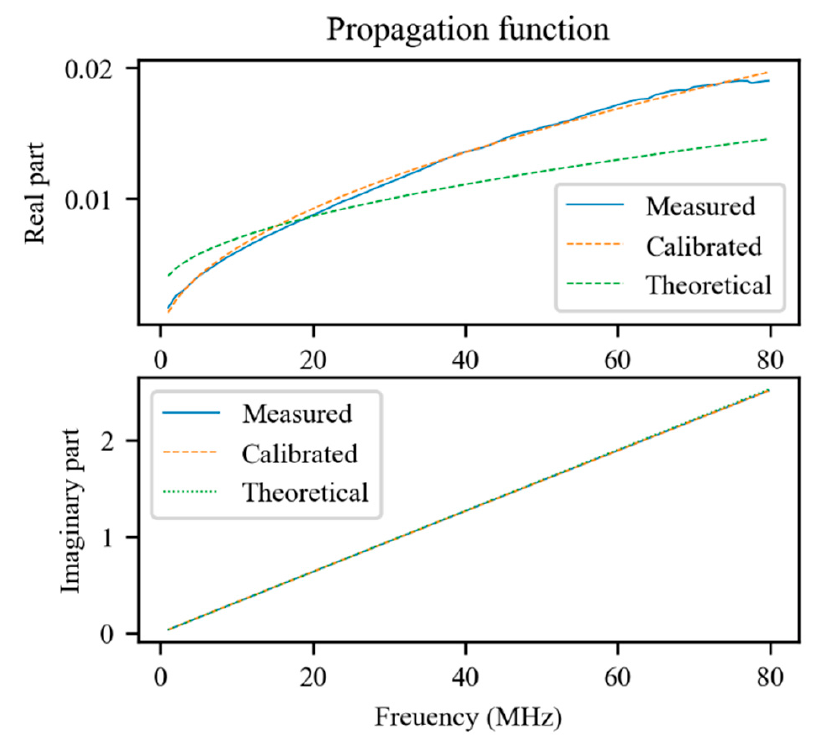
Figure 6. Comparison between the measured propagation function of the transmission line, the theoretical one, and that resulting from the calibration process.